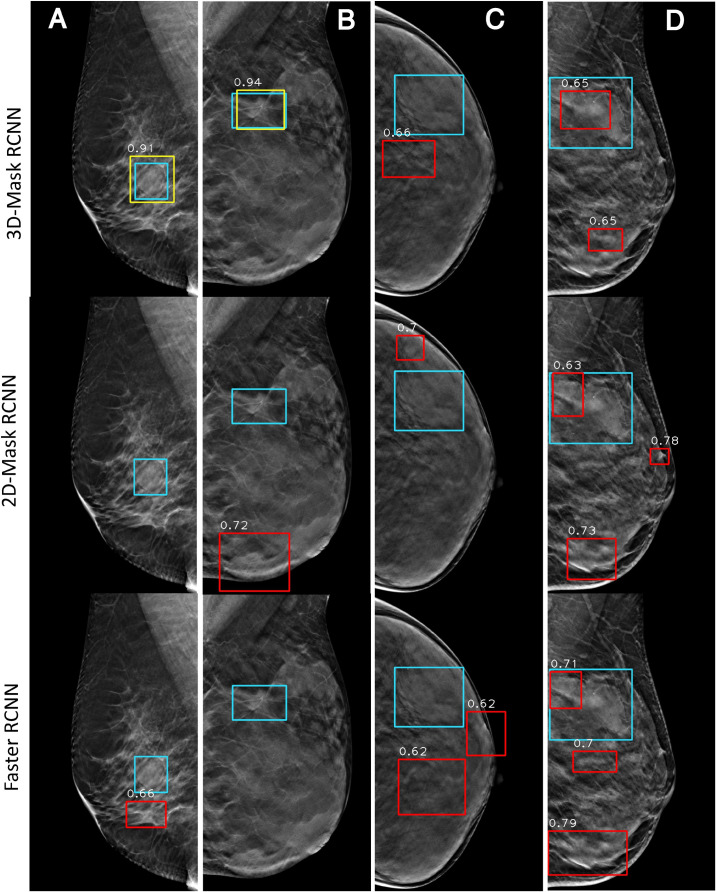
Examples of mass detection results for the 3D-Mask RCNN, 2D-Mask RCNN and Faster RCNN in patients with dense breast. Four patients are included (from left to right) with the following characteristics: (A) aged 60 years, dense breast, benign tumor, oval mass, and maximum tumor diameter of 24.62 mm; (B) aged 30 years, dense breast, malignant tumor, spiculate mass, and maximum tumor diameter of 38.35 mm; (C) aged 43 years, dense breast, malignant tumor, irregular mass, and maximum tumor diameter of 46 mm; and (D) aged 51 years, dense breast, malignant tumor, irregular mass, and maximum tumor diameter of 59.82 mm (green: ground truth box, yellow and red: detection box).